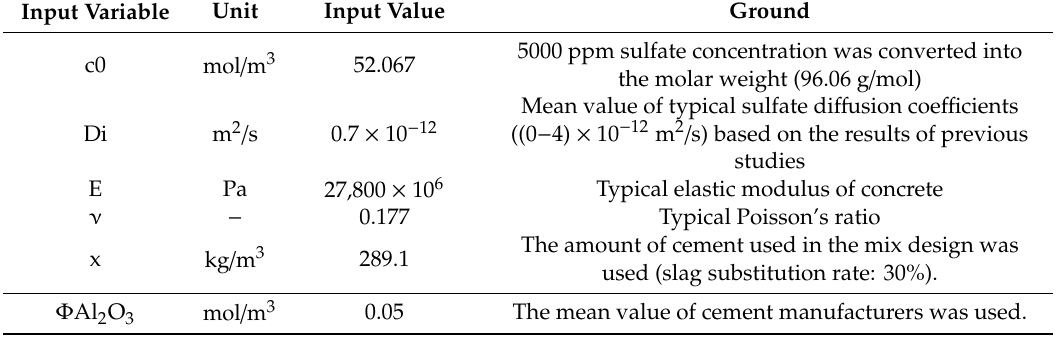
Figure 3. Results from chloride diffusion coefficient in various slime coating conditions. NB: Non-Bacteria; NBP: Non-Bacteria-Polymer; EVI: EV-Immob; EVIP: EV-Immob-Polymer; NI: Non-Immob; NIP: Non-Immob- Polymer.